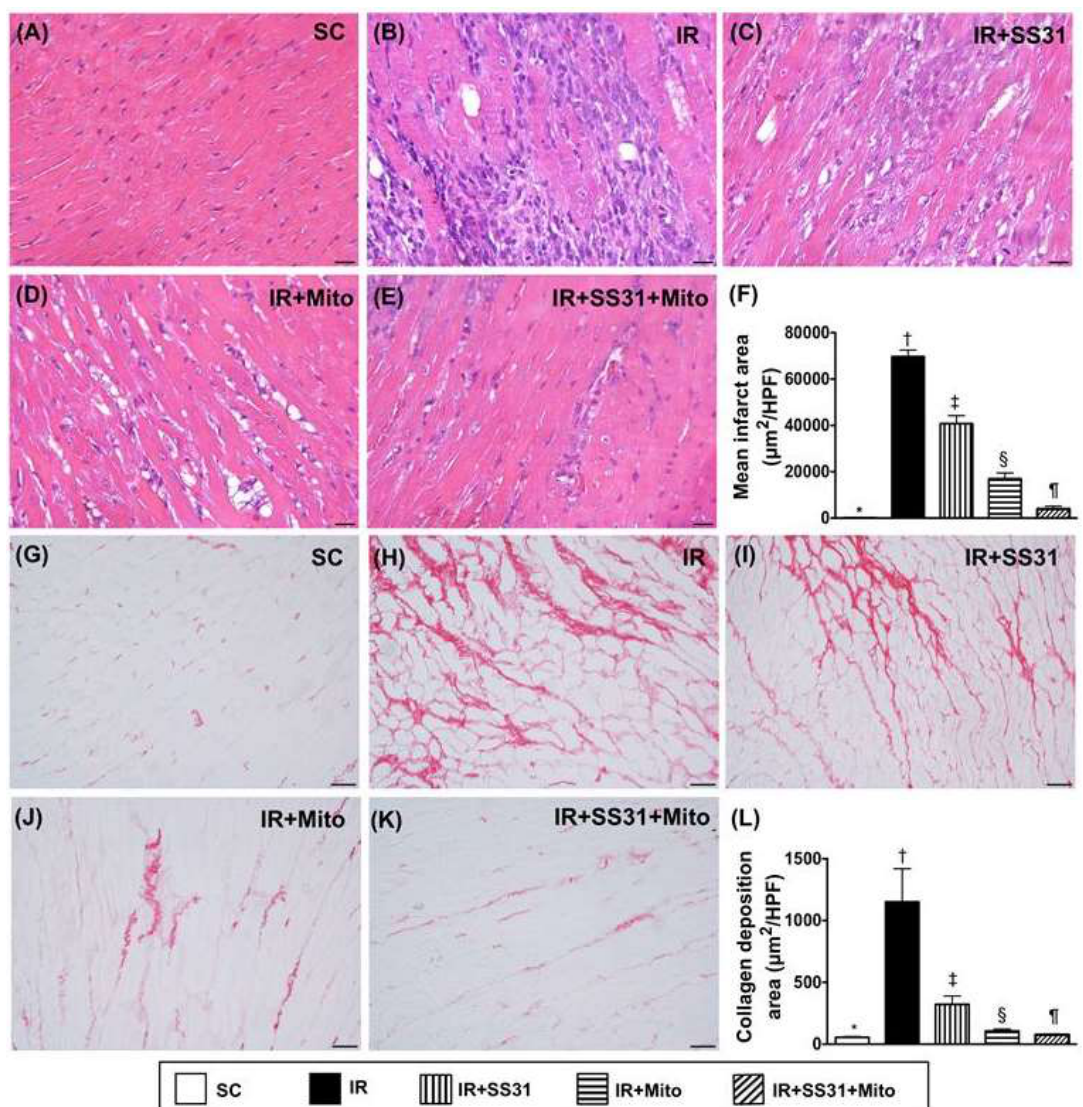
Figure 9. Infarct and collagen-deposition areas in the LV myocardium after the IR procedure. ( A – E ) Showing the light microscopic finding (400 × ) of H.E., stain in order to identify the infarct area (white-blue color). Scale bars in the right lower corner represents 20 µ m. ( F ) Analytical result of the infarct area * vs. other groups with different symbols (†, ‡, §, ¶), p < 0.0001. ( G – K ) Illustrating the microscopic finding (200 × ) of Sirius red satin for the identification of collagen deposition area (pink color). ( L ) Analytical result of the collagen deposition area * vs. other groups with different symbols (†, ‡, §, ¶), p < 0.0001. Scale bars in the right lower corner represent 50 µ m. All statistical analyses were performed by one-way ANOVA, which was followed by the Bonferroni multiple comparison post hoc test ( n = 8 for each group). Symbols (*, †, ‡, §, ¶) indicate significance at the 0.05 level. SC = sham control, IR = ischemia-reperfusion, and Mito = mitochondria.